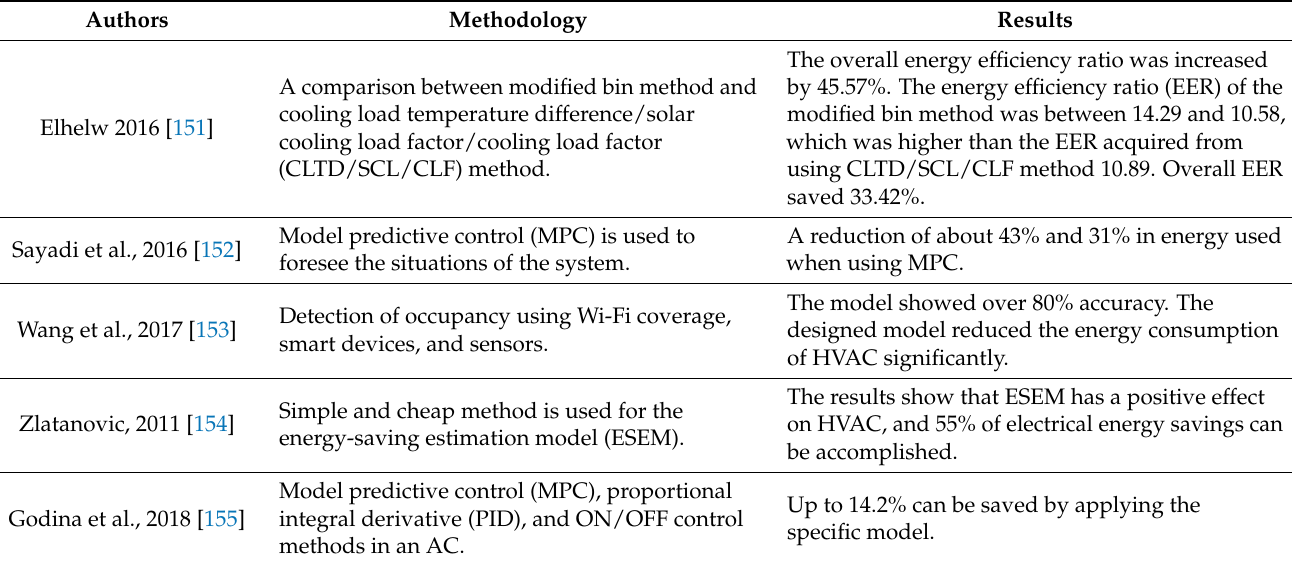
Table 6. Summary of the investigated papers related to mathematical control effect on HVAC